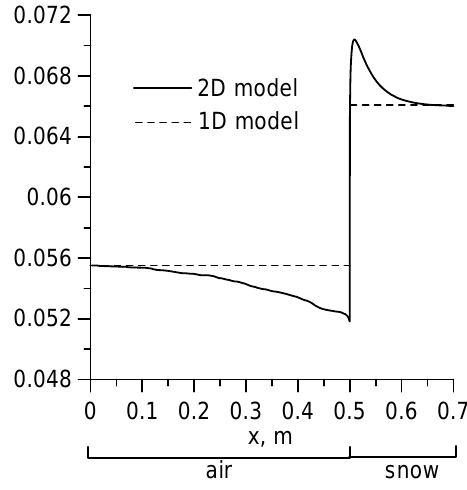
ˆ I(x) in the zenith direction (cid:127) ∗ on the Fig.10 Fig. 10. Relative intensity top boundary CS of the homogeneous snowpack. Width D = 1m, depth H = 0 . 7m, no black film, and the single scattering albedo = 0 . 999, for the 2-D and 1-D ω snow 0